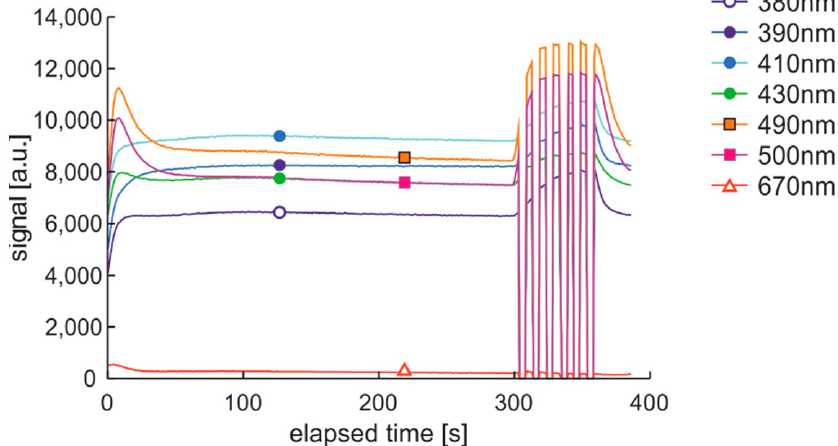
Figure 27. Time series of data of regular diesel fuel RDFU(s) in cycle DHE:UVonTon–zoom of the initial phase.